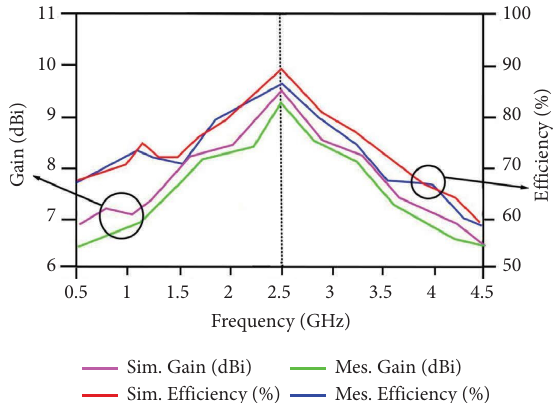
Figure 18: Simulated and measured gain and efciency of the proposed four-port MIMO antenna array.